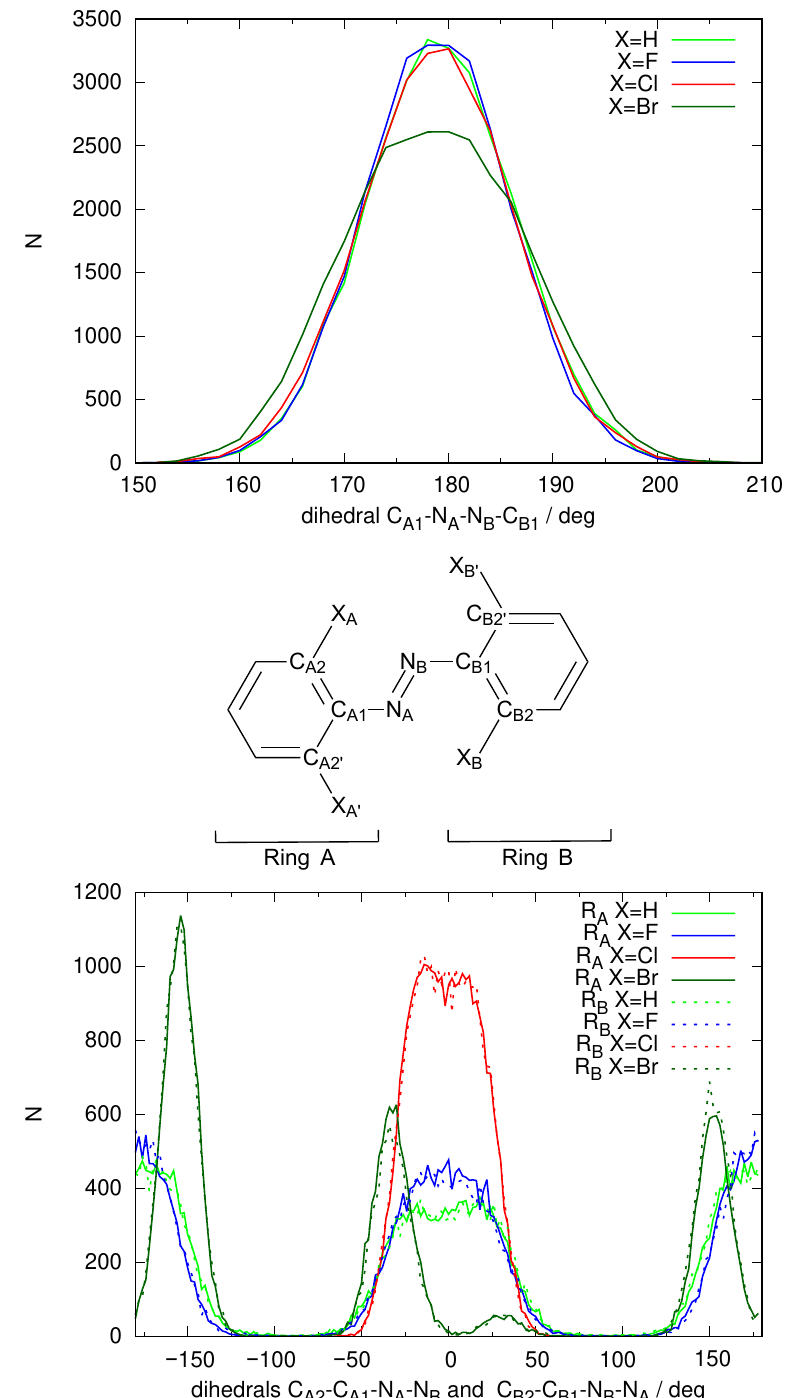
Figure 8. Distribution of specific geometric parameters over the 30 ns QM/MM MD simulation for the four azobenzene derivatives (X=H, F, Cl, Br), where the solute is described using DFTB. Labels of the atoms are defined in the central scheme. Top: distribution of the dihedral defining the E - Z configuration of the N=N double bond; Bottom: distribution of the dihedral defining the inclination of the phenyl groups with respect to the azo